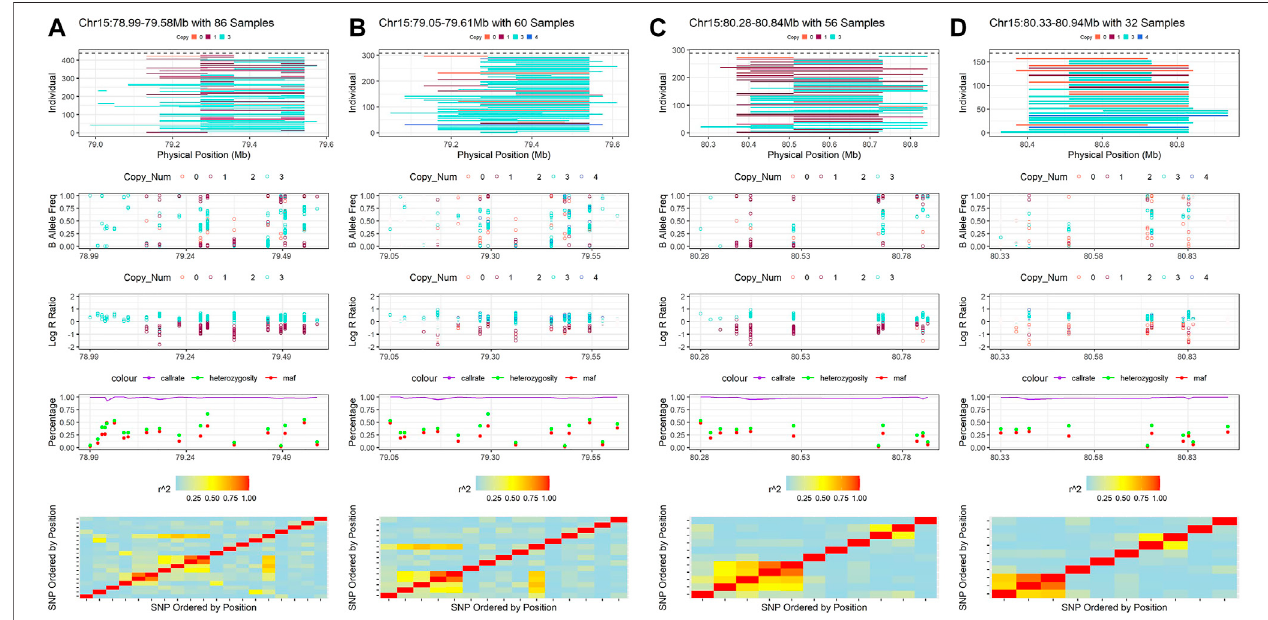
FIGURE 7 | Example of the consensus CNVR that detected by all inference strategies. (A) is the visualization result of CNVR of Penn-ARS. (B) is the visualization result of CNVR of Part-ARS. (C) is the visualization result of CNVR of Penn-UMD. (D) is the visualization result of CNVR of Part-UMD.